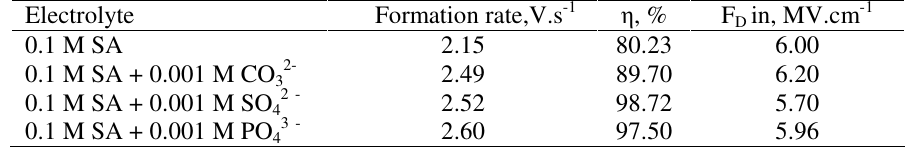
Table 3. Effect of added anion